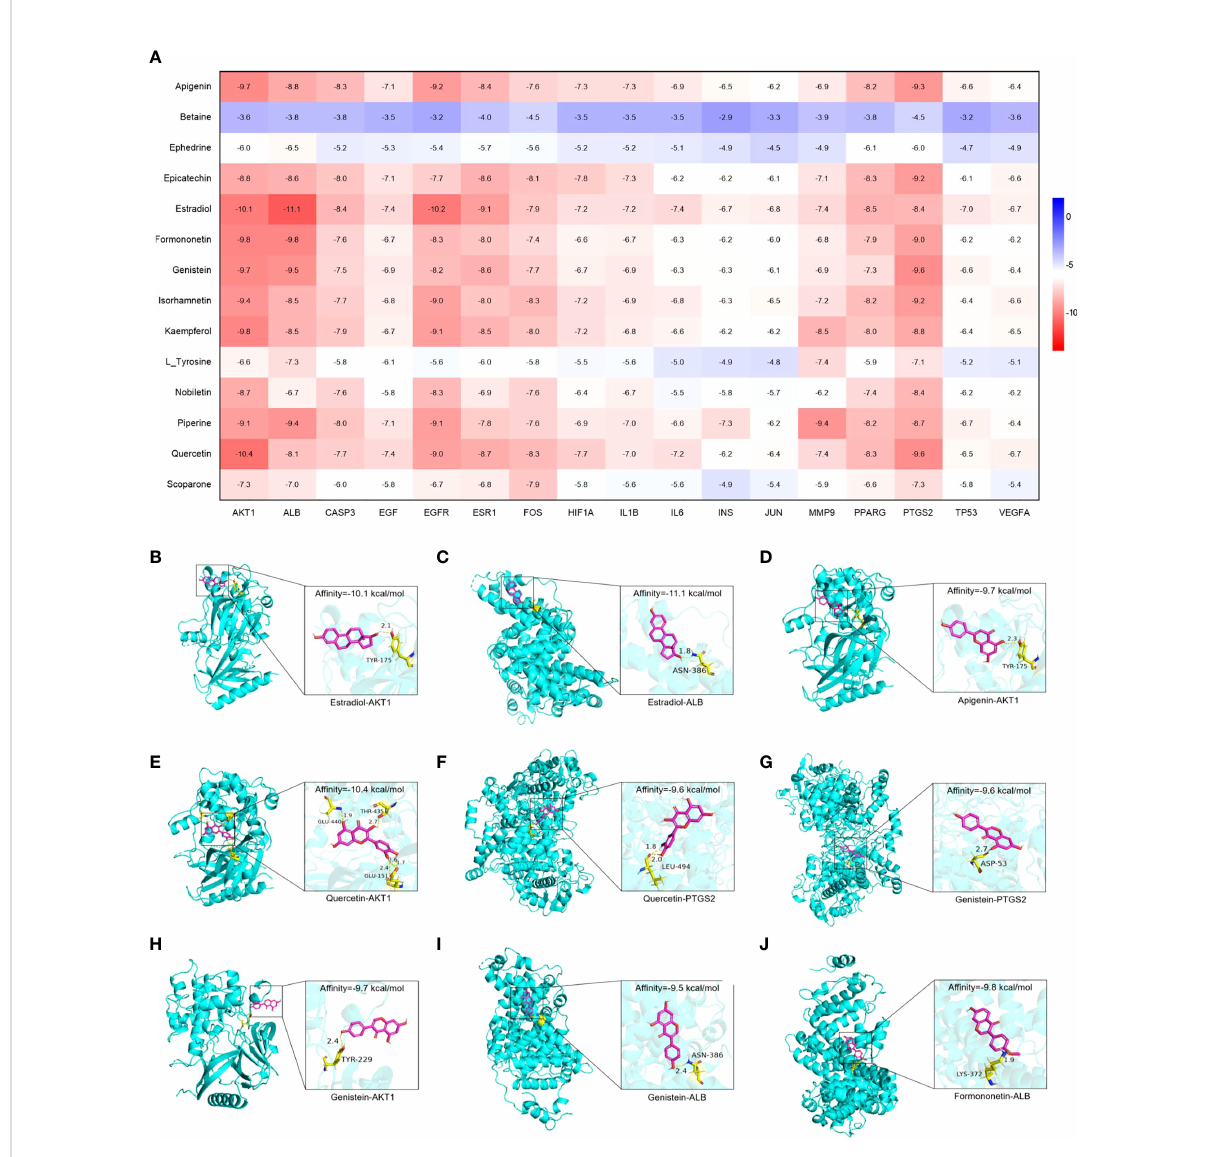
FIGURE 7 Molecular docking analysis of the main compounds and key targets. (A) Molecular docking heatmap. (B) Estradiol-AKT1. (C) Estradiol-ALB. (D) Apigenin-AKT1. (E) Quercetin-AKT1. (F) Quercetin-PTGS2. (G) Genistein-PTGS2. (H) Genistein-AKT1. (I) Genistein-ALB. (J)